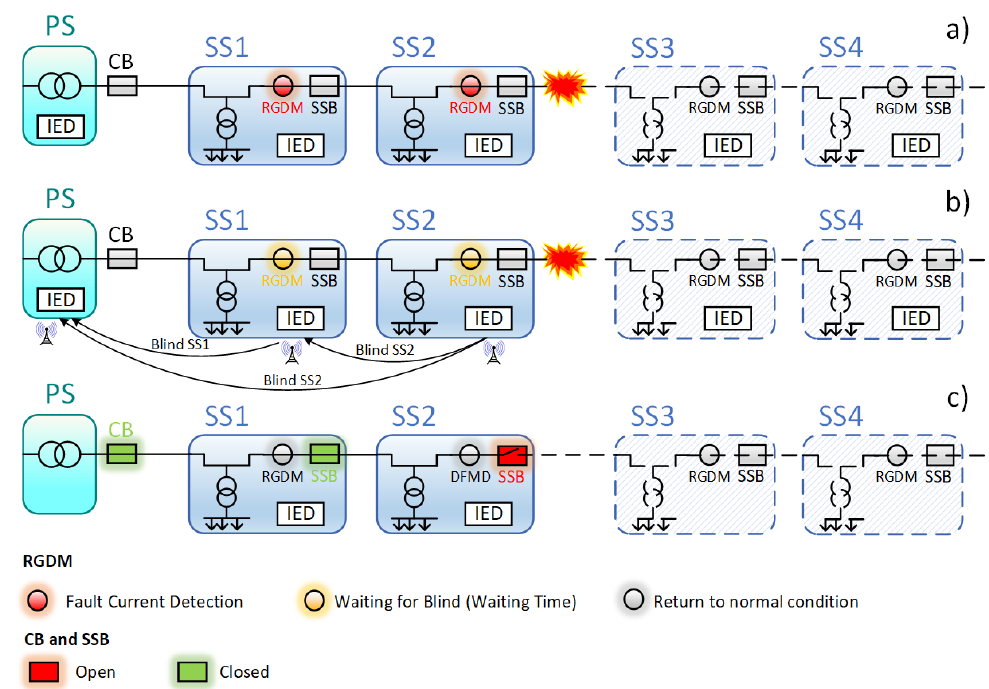
Figure 2. Automation steps according to the SFS approach; ( a ) fault occurrence and detection by RGDMs, ( b ) blind messages are sent upstream to prevent CB and SSB opening, ( c ) SS2 opens its SSB, since it does not receive the blind